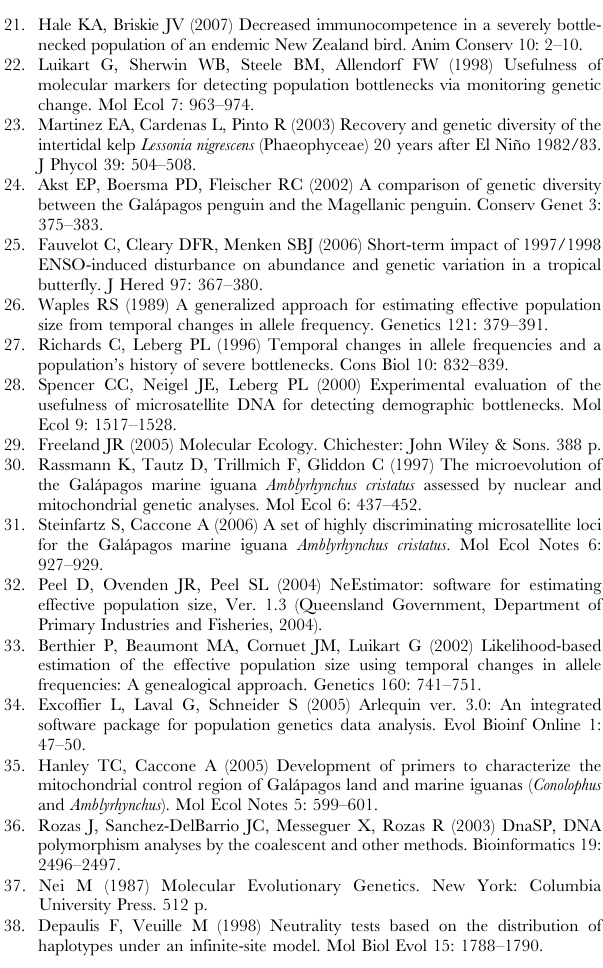
Figure S1 Graphical display of the TM3 results (estimates of the effective population size [Ne] generated from the temporal variance of allele frequencies using a likelihood-based approach) as provided by the program NeESTIMATOR.